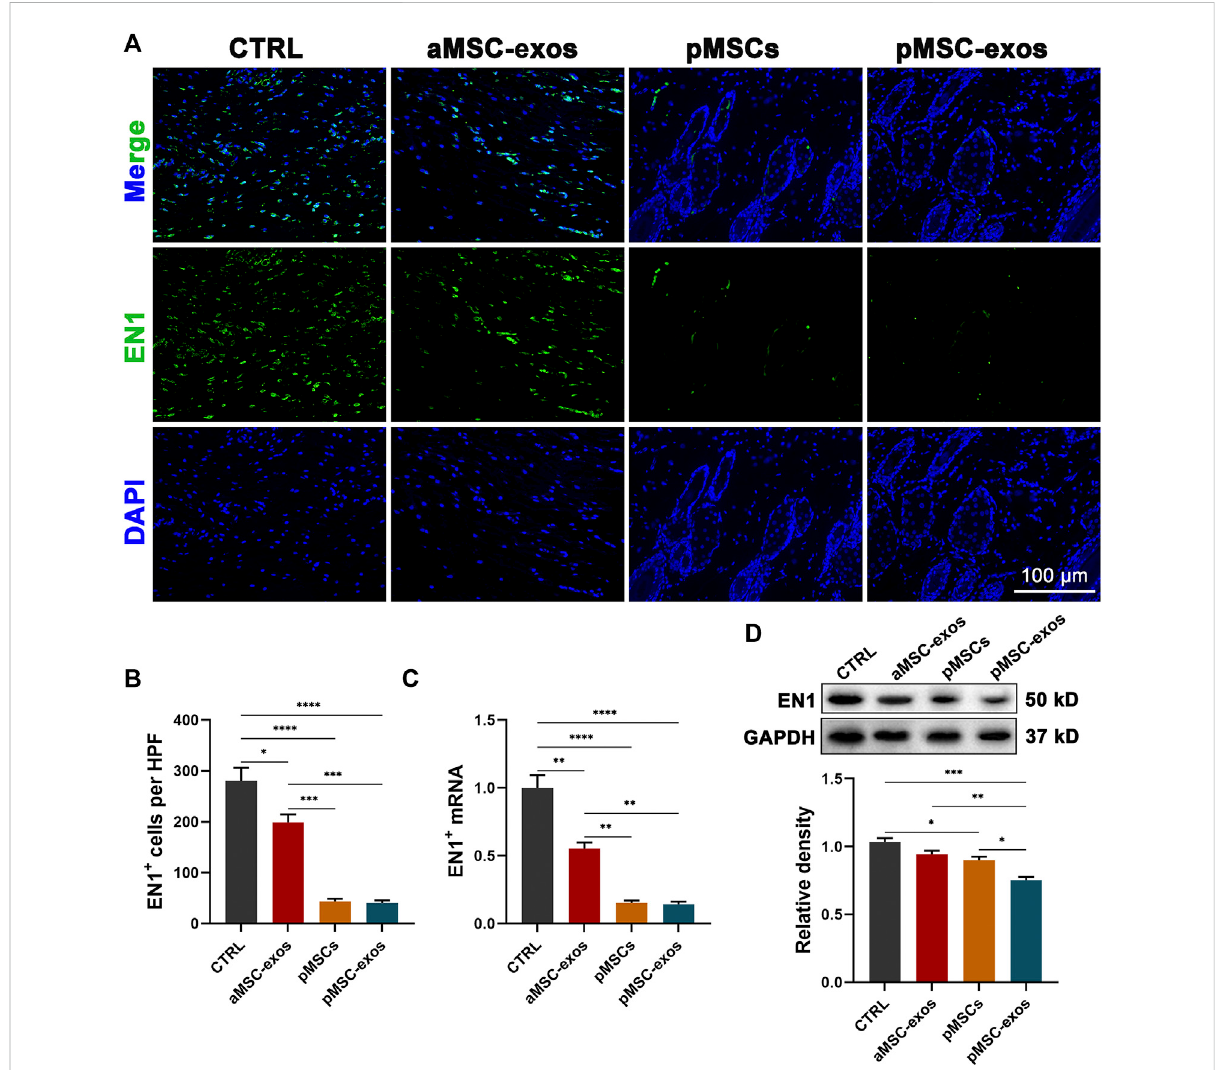
FIGURE 6 pMSC-exos prevent EN1 activation in wound healing. (A) EN1 IF staining of the healed skin. (B) Number of EN1 + cells per HPF according to IF staining. (C) mRNA levels in the healed skin via qRT-PCR. (D) Protein (EN1) levels in the healed skin via western blot. Mean ± SEM; * p < .05, ** p <